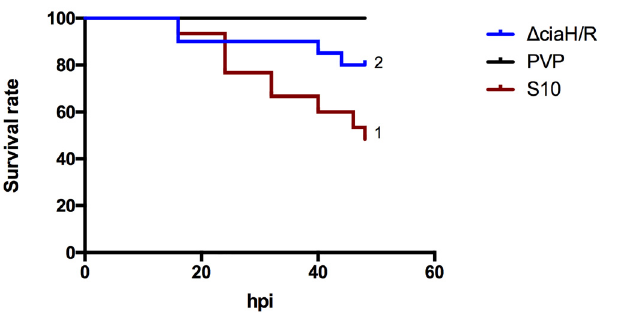
Fig 7. Increased survival rate of zebrafish larvae injected with S10 Δ ciaRH compared with the wild- type strain. Survival curve of injected larvae with S. suis S10, its mutant strain Δ ciaRH and control. Larval viability was checked every 8h for the first 40h, then every 2h. (1) p < 0.01 compared with Δ ciaRH and PVP control curves. (2) p < 0.01 compared with S10 and PVP control curves. Results were obtained in 3 independent experiments, and 25 larvae were injected per